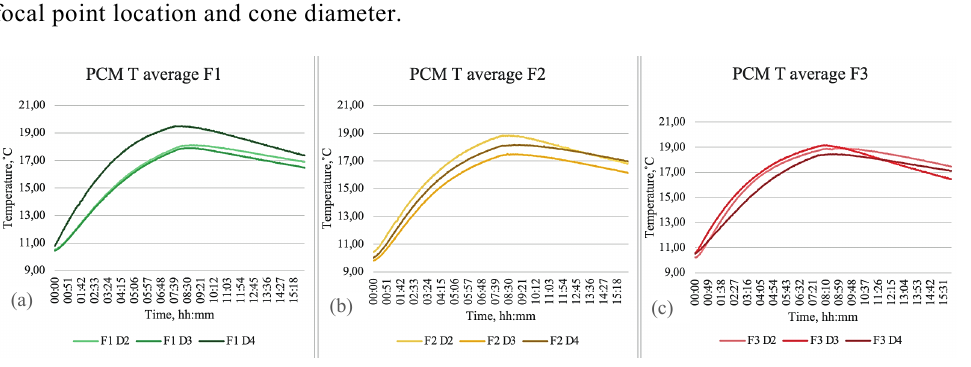
Fig. 6. Average temperatures in PCM container in all the Setups by focal point location: (a) – F1, (b) – F2 and (c) – F3.